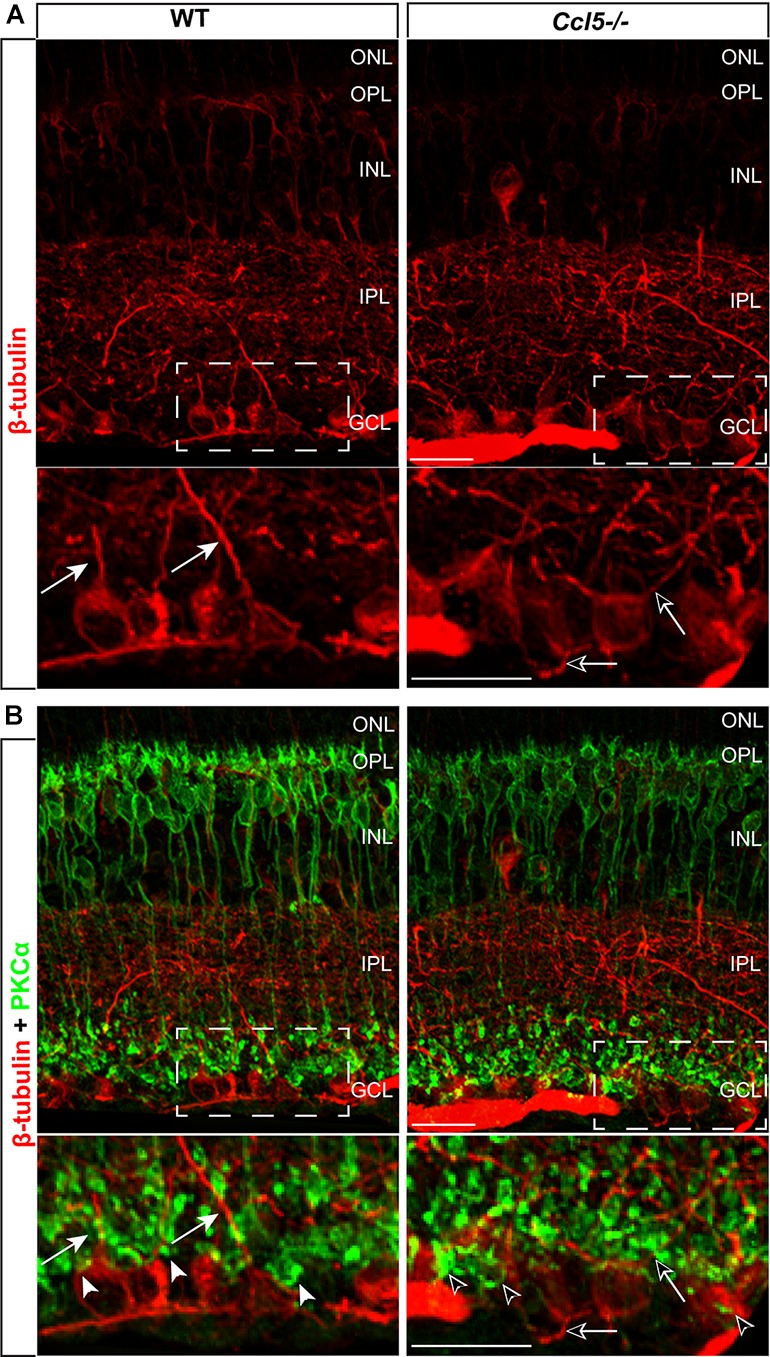
Ccl5 deficiency alters the organizational morphology of RGC dendrites. (A) Representative confocal micrographs (60x) of retina from WT (left) and Ccl5-/- mice (right) immunolabeled with primary antibodies against beta-tubulin (β-tubulin; red) reveal disorganized trajectories of dendritic projections in Ccl5-/- retina (unfilled arrows), as compared to the uniform, upright trajectory observed in WT retina (filled arrows). Bottom panels are higher magnification views of the outlined area in top panels. Scale = 20 μm. (B) Representative confocal micrographs (60×) of retina from WT (left) and Ccl5-/- mice (right) co-immunolabeled with primary antibodies against β-tubulin (red) and PKCα (green) reveal that terminals of PKCα+ rod bipolar cells (unfilled arrowheads) encroach into the GCL and surround β-tubulin+ RGC soma. In contrast, terminals of PKCα+ rod bipolar cells in WT retina contact only the apical surface of β-tubulin+ RGC soma (filled arrowheads). Bottom panels are higher magnification views of the outlined area in top panels. Scale = 20 μm.